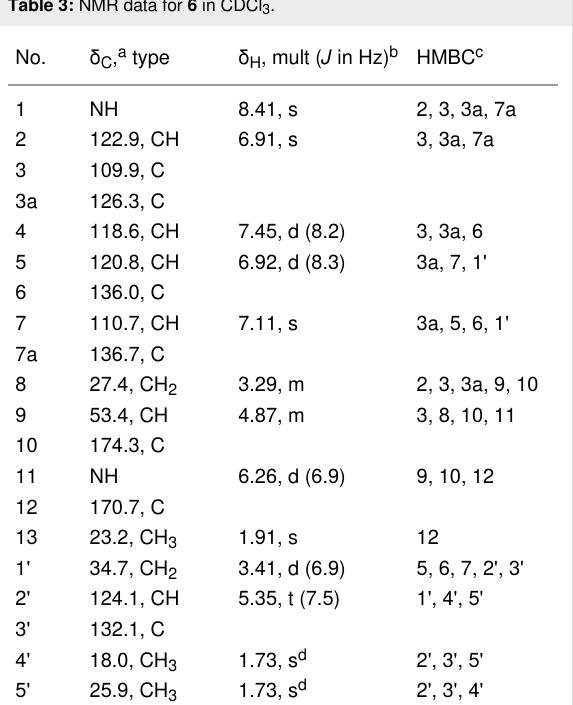
Table 3: NMR data for 6 in CDCl 3